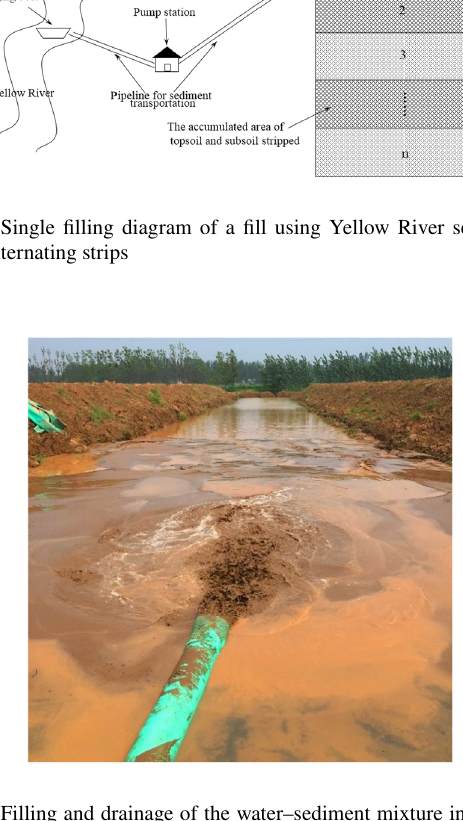
Fig. 4 Filling and drainage of the water–sediment mixture in the rec- lamation strip. a Filling; b